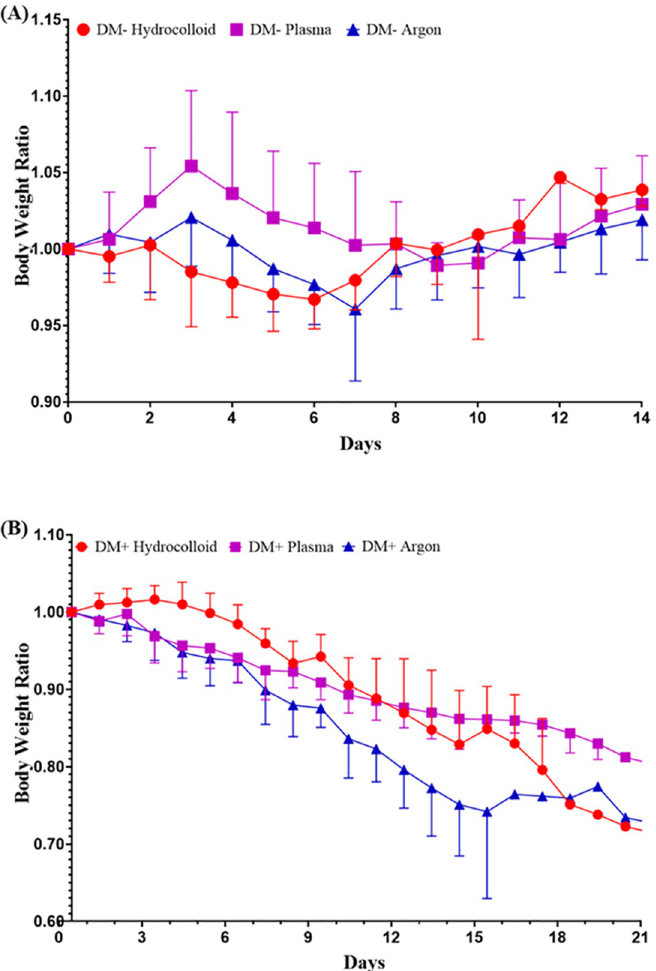
Fig 4. Daily body weight ratio. A comparison of daily body weights with initial body weights. (A) The body weight ratio in the DM- group is presented as the mean ± SD of five mice and (B) the body weight ratio in the DM+ group as the mean ± SD of four